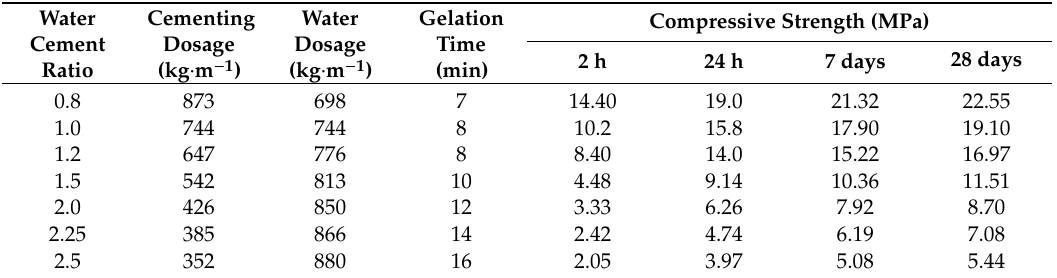
Table 5. Uniaxial compressive strength of high-water material under different water–cement ratios.